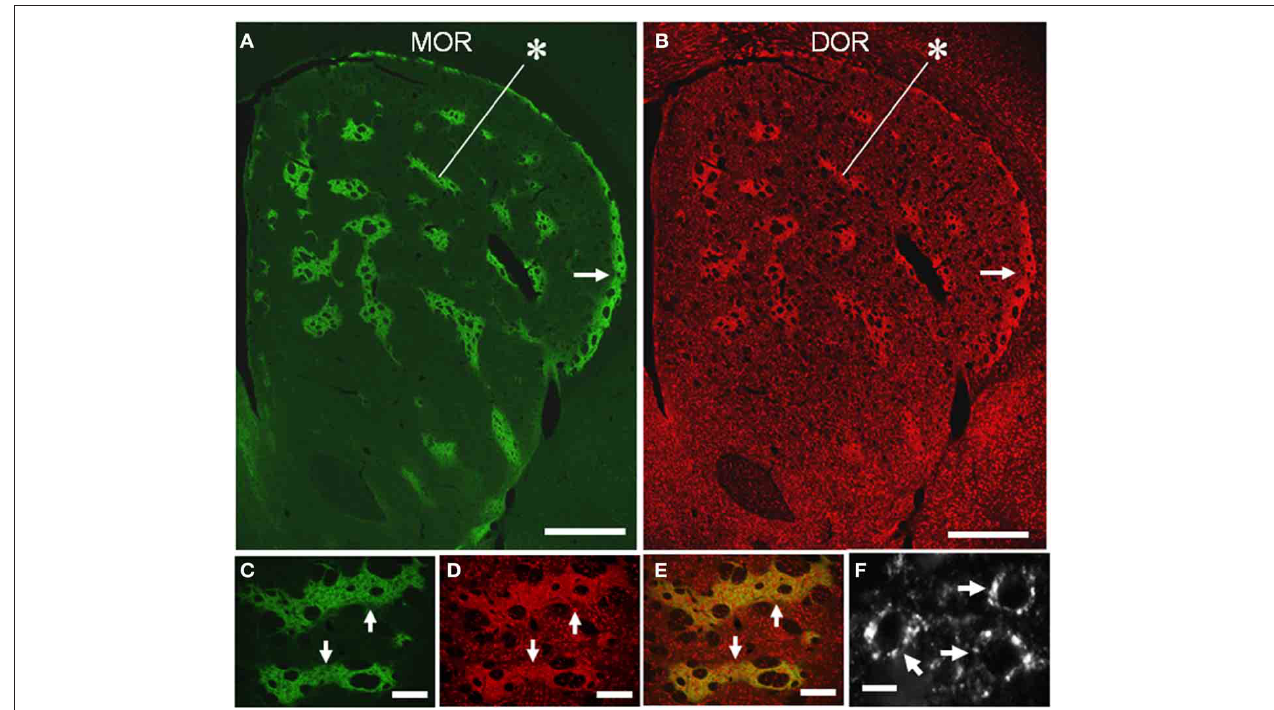
FIGURE 4 | Compartmental and cellular localization of DORs in the rat striatum. (A,B) Representative images of striatal sections double-stained for MOR (A) and DOR (B) . Asterisks indicate a corresponding striosome, and arrows do the subcallosal streak. (C–E) Photomicrographs of the striosomes (arrows) double-stained for MOR (C)